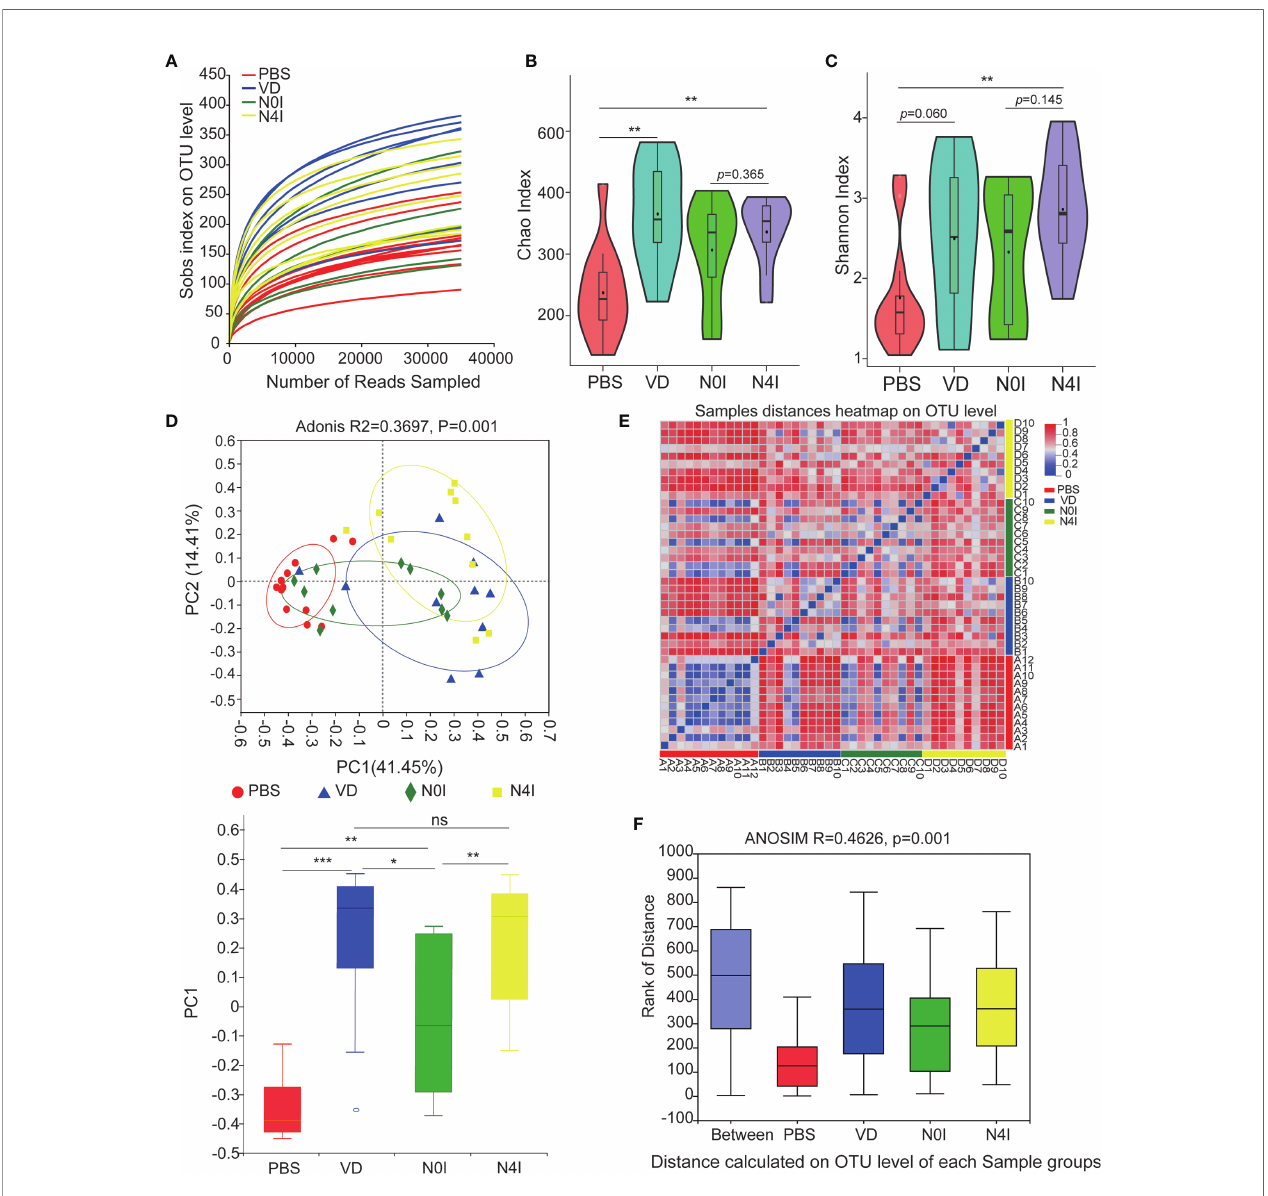
FIGURE 2 | Diversity estimate calculations of bacterial OTUs between control, VD, and mCRAMP-encoding L. lactis – treated mice. (A) Rarefaction curve was generated to determine the sequencing depth per sample. (B, C) The Chao1 and Shannon indexes of control, VD, and mCRAMP-encoding L. lactis – treated mice were calculated to estimate bacterial richness and diversity. Horizontal lines represent mean value. ** p < 0.01. p < 0.05 indicates statistical signi fi cance using a Welch ’ s t-test. (D) Principal component analysis (PCoA) were used to evaluate the bacterial community difference in each group by Bray-Curtis. PERMANOVA (Adonis) analyses were performed to evaluate the overall differences on OTU level between groups. The box plot showed the difference of microbial community on the fi rst principal coordinate (PC1), and the statistical differences were determined with Mann-Whitney test (*** p < 0.001, ** p < 0.01, * p < 0.05). (E) Heatmap using the Bray-Curtis distances was analyzed to assess sample distances at genus level based on the OTU results. (F) Distance boxplot with ANOSIM analysis indicated a signi fi cant difference overall the groups of samples (p < 0.05). (B, C) Were generated using an online tool ImageGP (http://www.ehbio.com/ImageGP/index.php/ Home/Index/index.html), and (E) was performed by R software using vegan package. ns, not signi fi